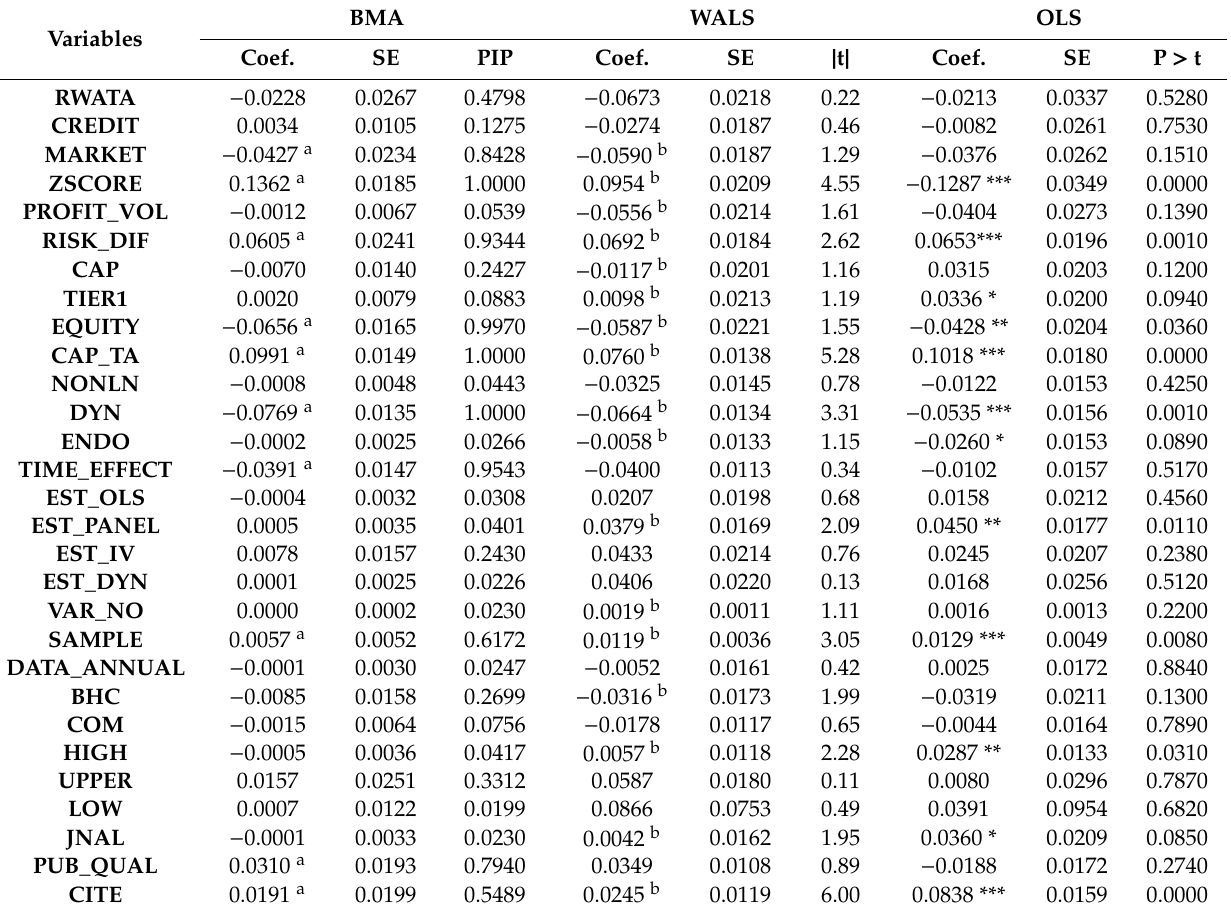
Table 4. Bayesian model averaging